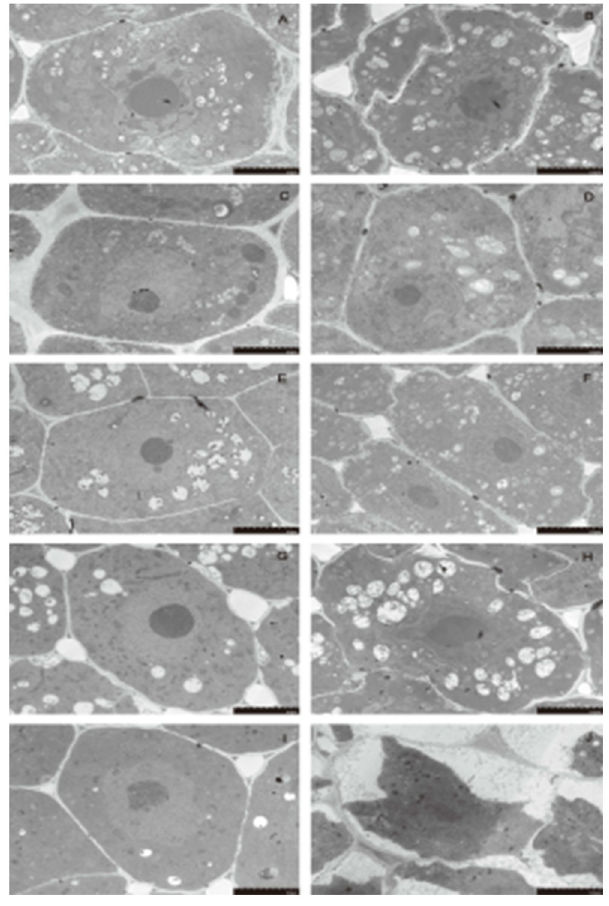
Fig 4. Subcellular structure of meristematic cells from mung bean hypocotyls in different preimbibition and dehydration states. A, C, E, G and I show meristematic cells of the hypocotyl with 0, 3, 6, 18 and 24 h of preimbibition, respectively. B, D, F, H and J show meristematic cells of the hypocotyl with 0, 3, 6, 18 and 24 h of preimbibition after 24 h of dehydration, respectively.